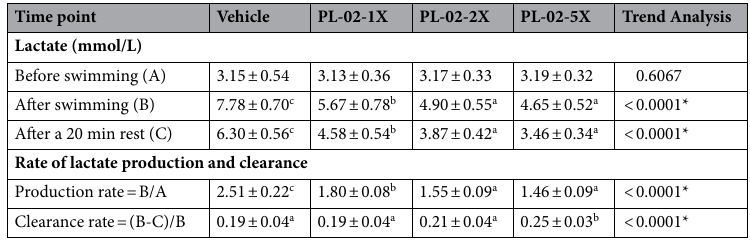
Table 2. Effect of PL-02 on lactate levels. Lactate production rate (B/A) was the value of the lactate level after exercise (B) divided by that before exercise (A). Clearance rate (B − C)/B was defined as lactate level after swimming (B) minus that after 20 min rest (C) divided by that after swimming (B). Data are expressed as mean ± SD ( n = 10 mice per group). Values in the same row with different superscript letters (a, b, c, d) differ significantly, p < 0.05.